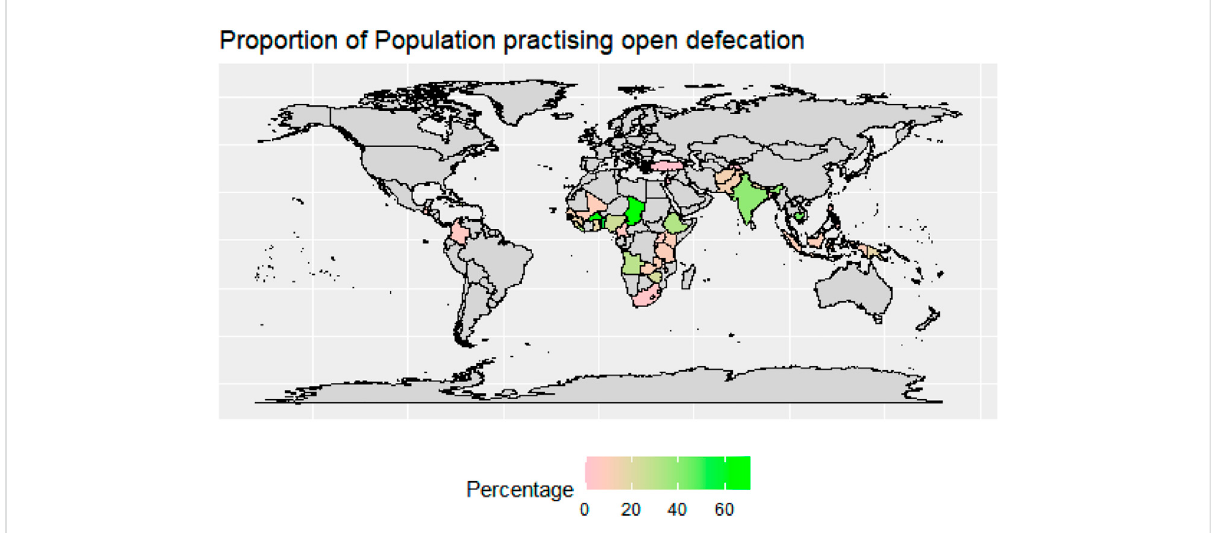
FIGURE 5 Proportion of population practicing open defecation in the study countries. Note: Proportion estimated as the share of sampled households practicing open defecation to the total sampled households by countries. Source: Authors estimation based on the DHS